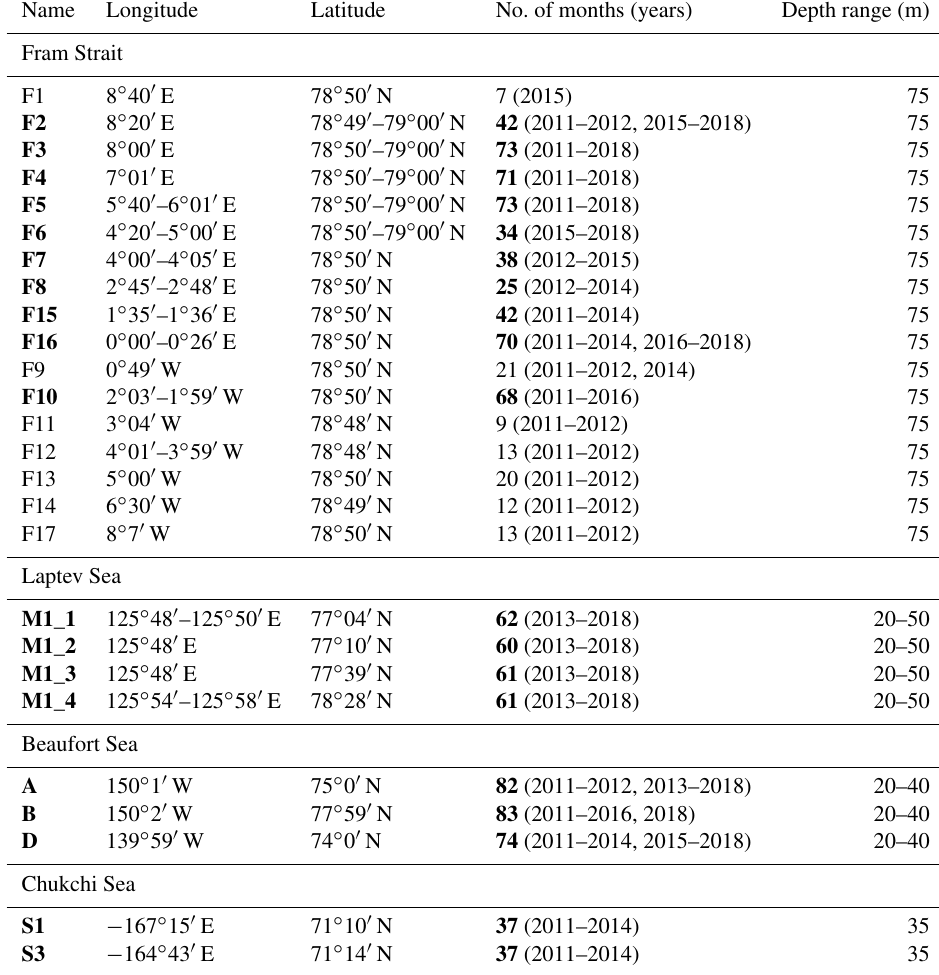
Table 2. Names, locations, monthly data availability and averaging depth ranges for the seafloor moorings used as a comparison dataset to validate altimetry-derived geostrophic velocity; moorings are located across the Fram Strait (first 17 rows), across the Laptev Sea continental slope (following 4 rows), in the Beaufort Sea (following 3 rows) and in the eastern Chukchi Sea (last 2 rows). Variable locations indicate the relocation of the moorings in some years; in the third column, values in parentheses indicate the years of data availability. Data from mooring records longer than 24 months (in bold) were used to compute the correlation with